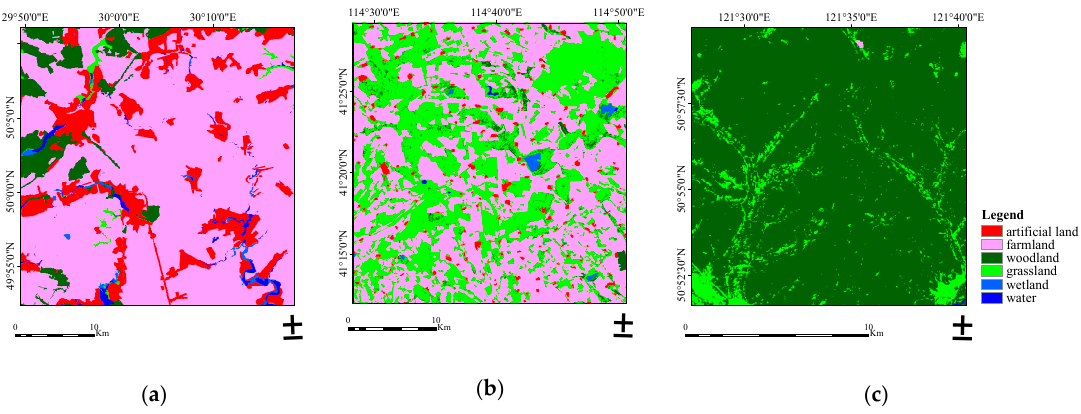
Figure 1. Land cover maps in farmland ( a ), grassland ( b ), and woodland ( c ).